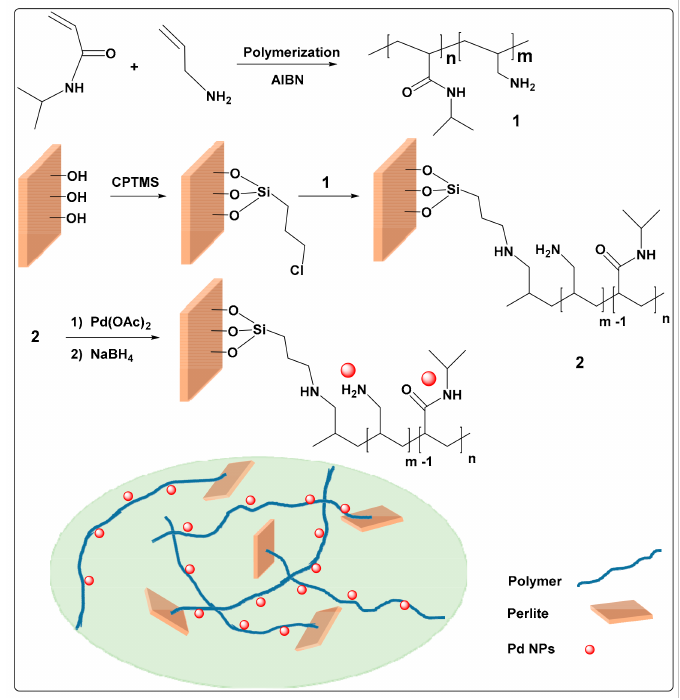
Figure 1. Synthetic method for the preparation of